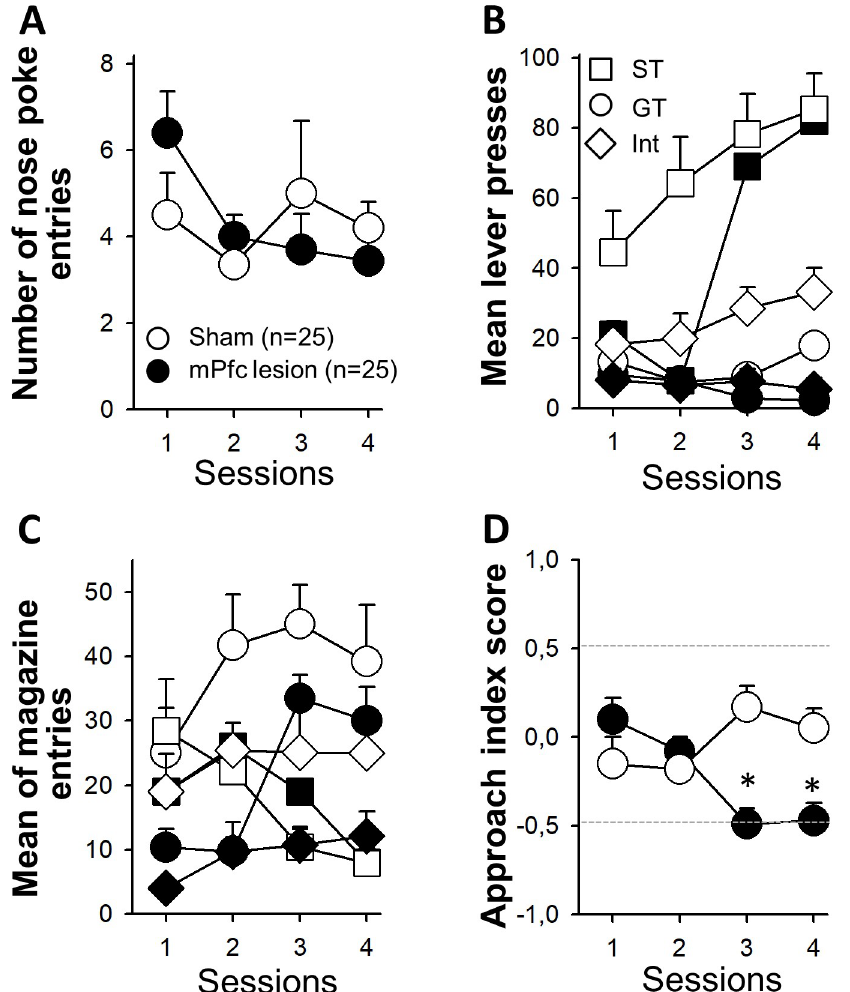
Fig 2. A. Entries to nose poke device in sham (open circles) and mPFC lesioned (black circles) animals. The figure includes the mean and standard error from session 1 to 4 for each group including all animals. Dotted lines show the limits between phenotypes. B. Mean of lever-press behavior and magazine entries (C) when CS was presented in ST (filled and white squares), GT (filled and white circles), and Int (filled and white diamonds) groups. Filled and open symbols indicate sham or mPFC groups, respectively. D. Approach Index Score of Sham and mPFC-lesioned rats. Asterisk indicate significant differences between sham and mPFC lesioned